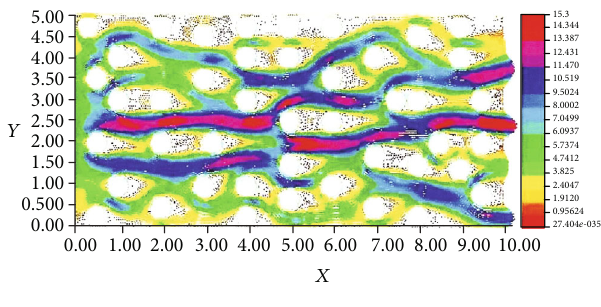
Figure 9: Velocity pro fi le at Re = 10 .